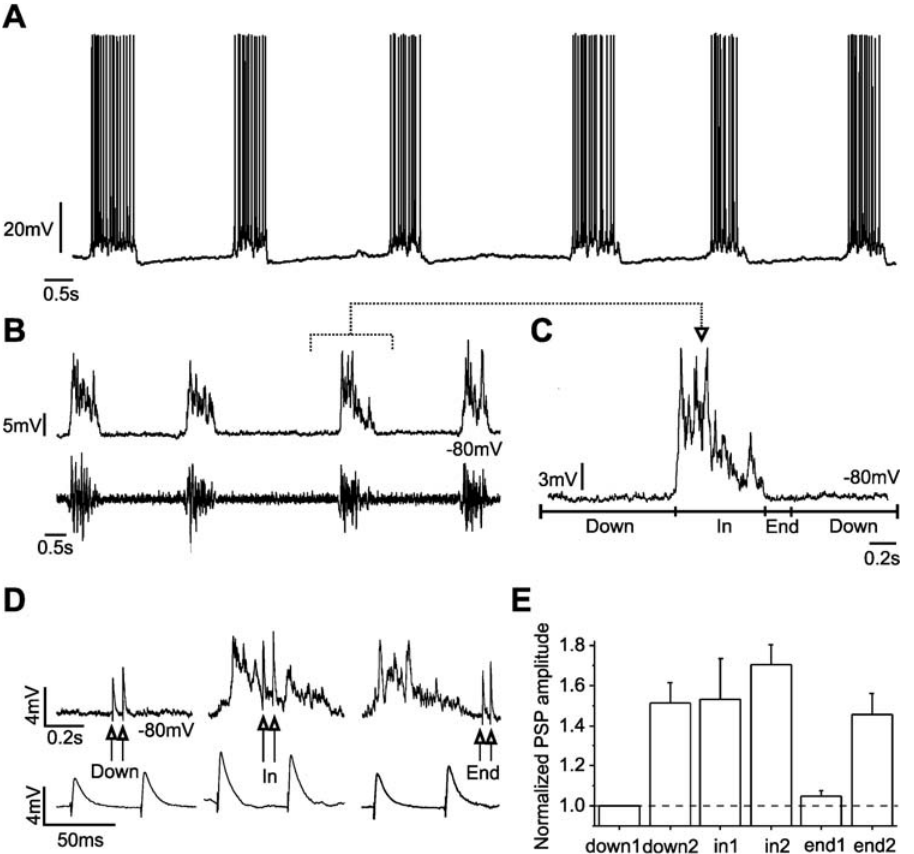
Figure 3. Paired pulse facilitation in up versusdown states in the cortex invitro.A. Six up states interspersed with down, silent states recorded from a layer 2/3 neuron in primary visual cortex of the ferret in vitro . B. Four up states (top trace) and the corresponding multiunit activity recorded in the vicinity of the neuron (bottom trace). The intracellular recordings were kept subthreshold by means of current injection. C. Expanded up state illustrating the time segments that will be used to sort out the time of occurrence of the PSPs: Down (down state periods excluding the 200 ms following an up state), In (up states) and End (200 ms following the occurrence of the up state). D. Raw traces of a pair of PSPs occurring during the Down , In and End periods (top trace). Averaged paired PSPs for the same neuron during the 3 periods with respect to the occurrence of the up states: Down, In and End (bottom trace) (n=8 PSPs have been averaged for each segment). E. Bar diagram illustrating the amplitude of the first and second PSP of the pair during the 3 time segments ( Down, In and End ) for intracortical synapses recorded in vitro . All the PSPs have been normalized with respect to the first PSP of the pair in the down states (n=9 neurons).